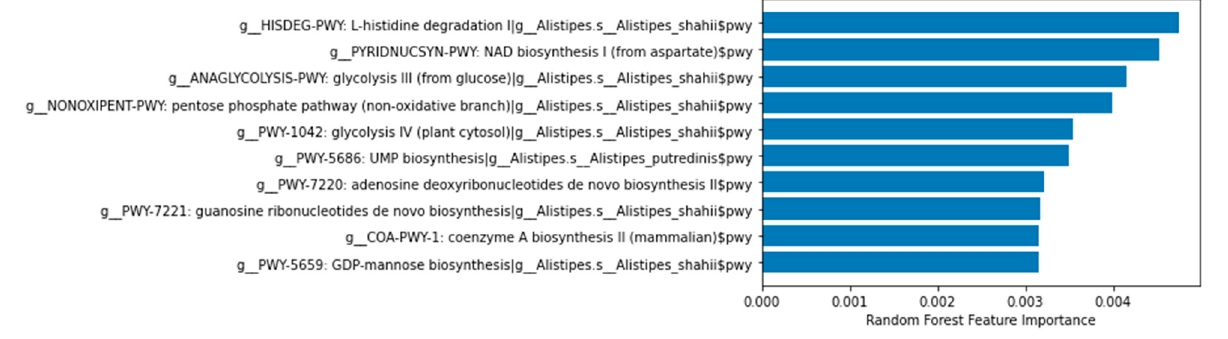
Figure 4. Feature importance (metatranscriptomics data) with a RF. Only the first ten features are shown for illustrative purposes. Generated with a Python script.